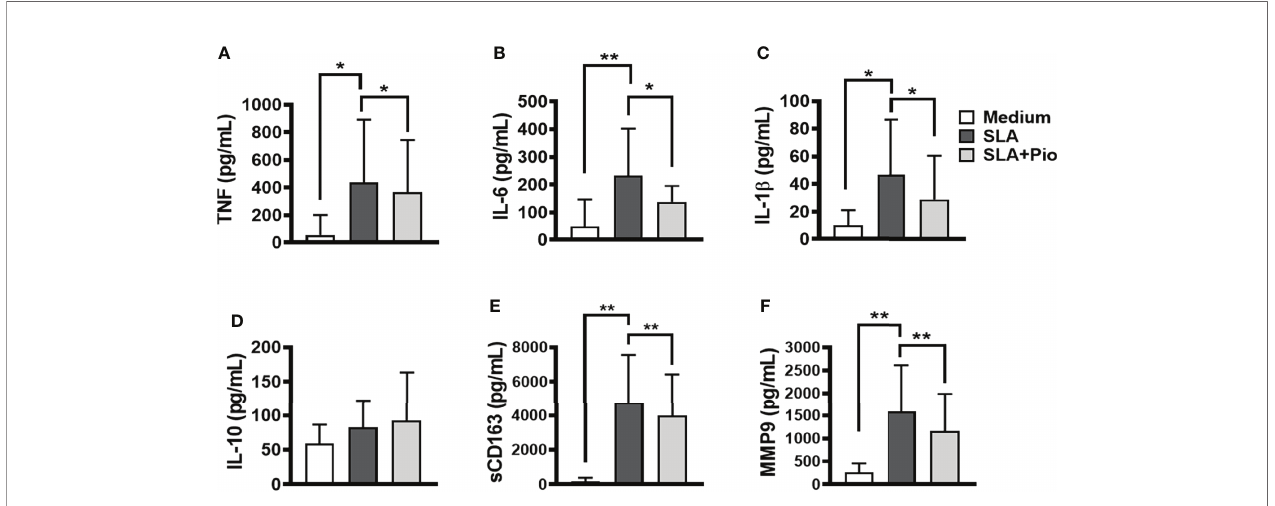
FIGURE 3 | Pioglitazone downregulates the production of in fl ammatory mediators induced by SLA . Peripheral blood mononuclear cells (PBMCs) from cutaneous leishmaniasis (CL) (n = 15) were cultured in the presence or absence of soluble Leishmania antigen (SLA) (5 m g/ml) or pioglitazone (1 m M) for 24 h. The levels of (A)